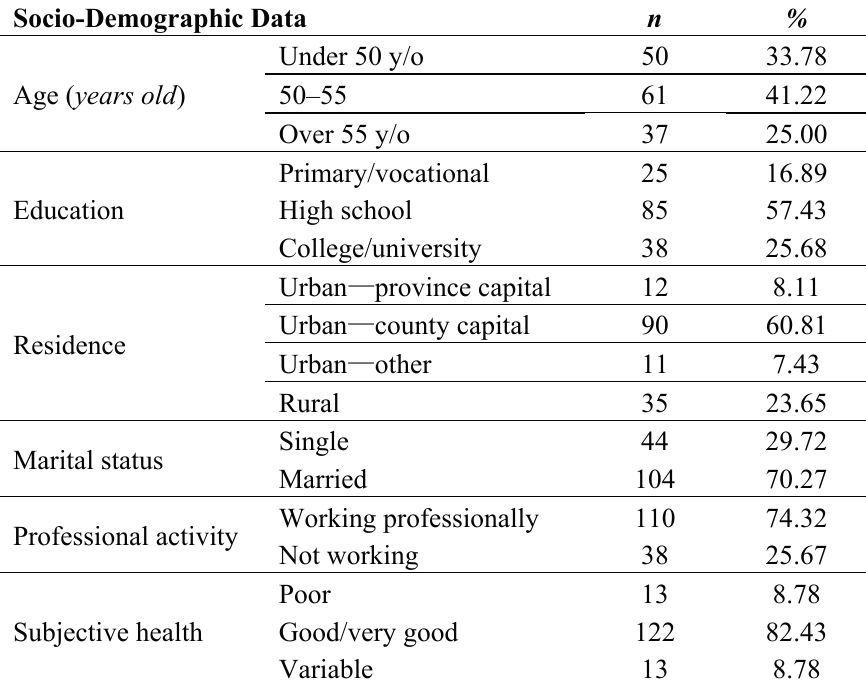
Table 1. Participants’ characteristics.